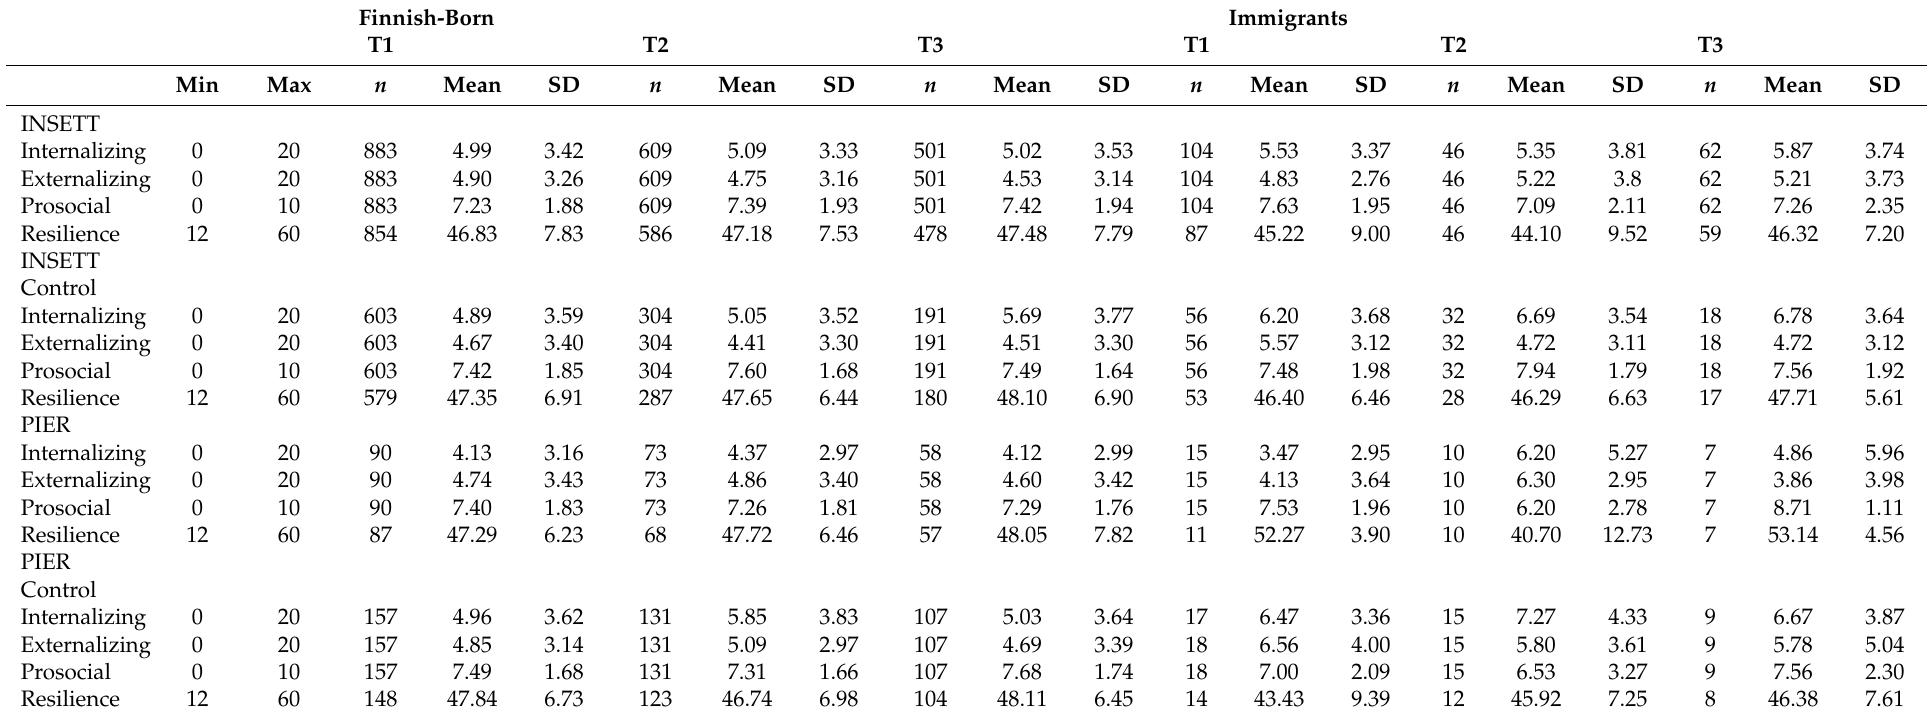
Table 3. Estimates for dependent